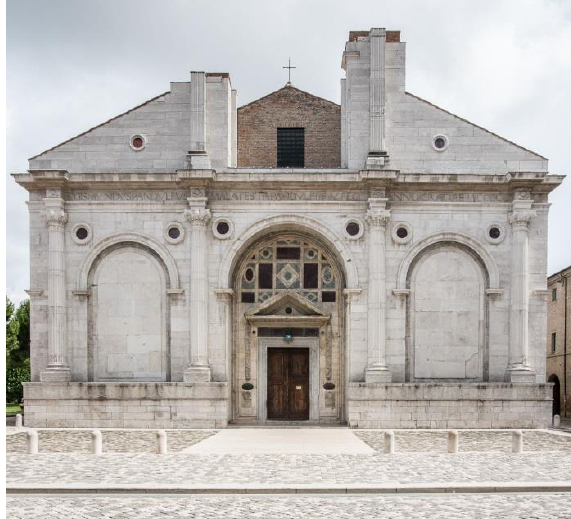
Fig. 6 The Malatestian Temple (Rimini, 1503)